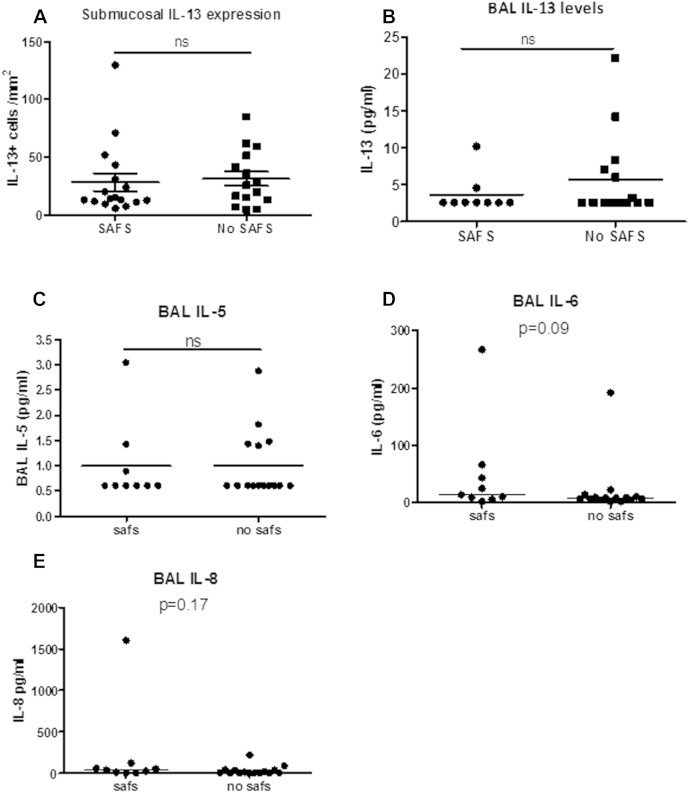
Endobronchial biopsy specimens from children aged 6 to 16 years with severe asthma were stained by means of immunohistochemistry for IL-13 expression. A, IL-13+ cells in the submucosa were counted and expressed per area of submucosa in children with SAFS compared with children with severe asthma without fungal sensitization (no SAFS). B-E, IL-13 (Fig E6, B), IL-5 (Fig E6, C), IL-6 (Fig E6, D), and IL-8 (Fig E6, E) levels in BAL fluid from children with SAFS and non-SAFS were quantified by using the Luminex multiplex assay (Bio-Rad). ns, Not significant.